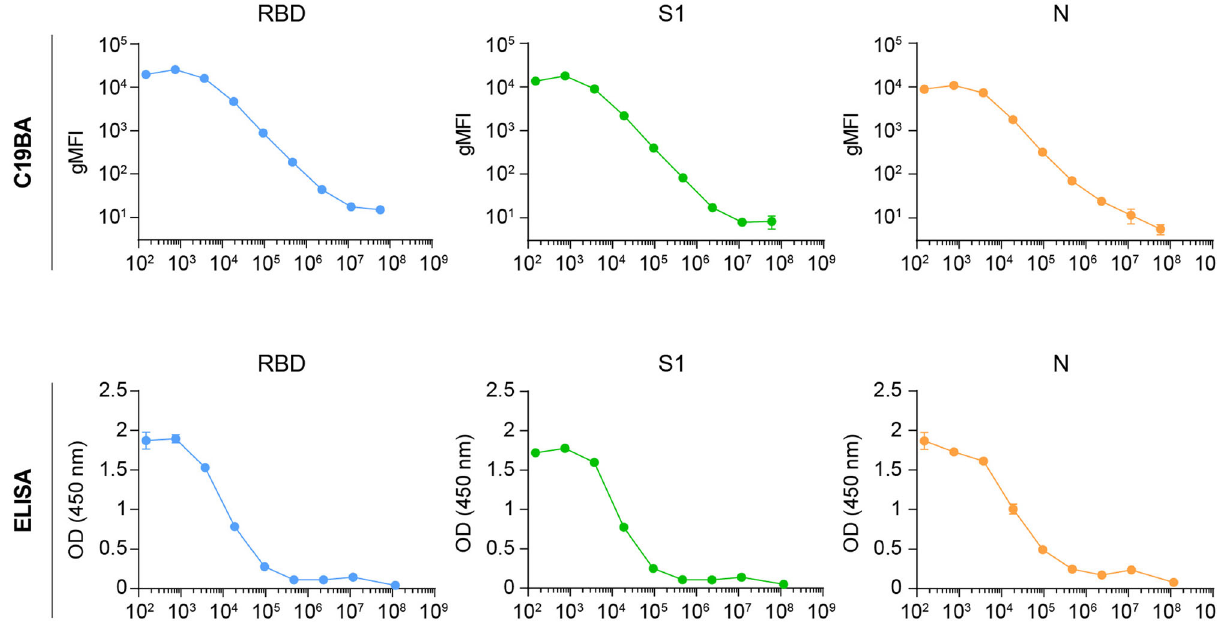
Fig. 2 C19BA has superior sensitivity and greater dynamic range than ELISA. Comparison of the titration of anti-RBD (blue and green) and anti-N (orange) IgG antibodies against recombinant RBD, S1, and N proteins by C19BA (top) and ELISA (bottom). The mean value of two replicates is shown; error bars represent